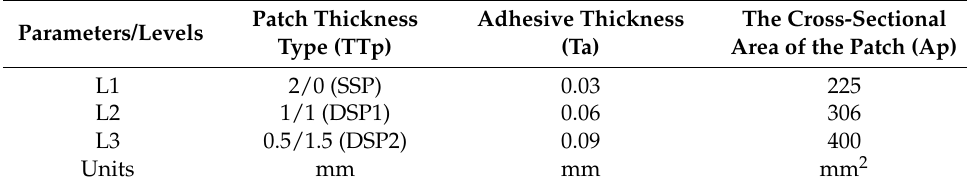
Table 3. Parameters and Levels (a = 10 mm).